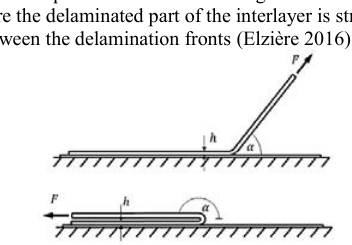
Fig. 4 Schematic representation of the Through Crack Tensile Test sample where the delaminated part of the interlayer is stretched in between the delamination fronts (Elzière 2016).